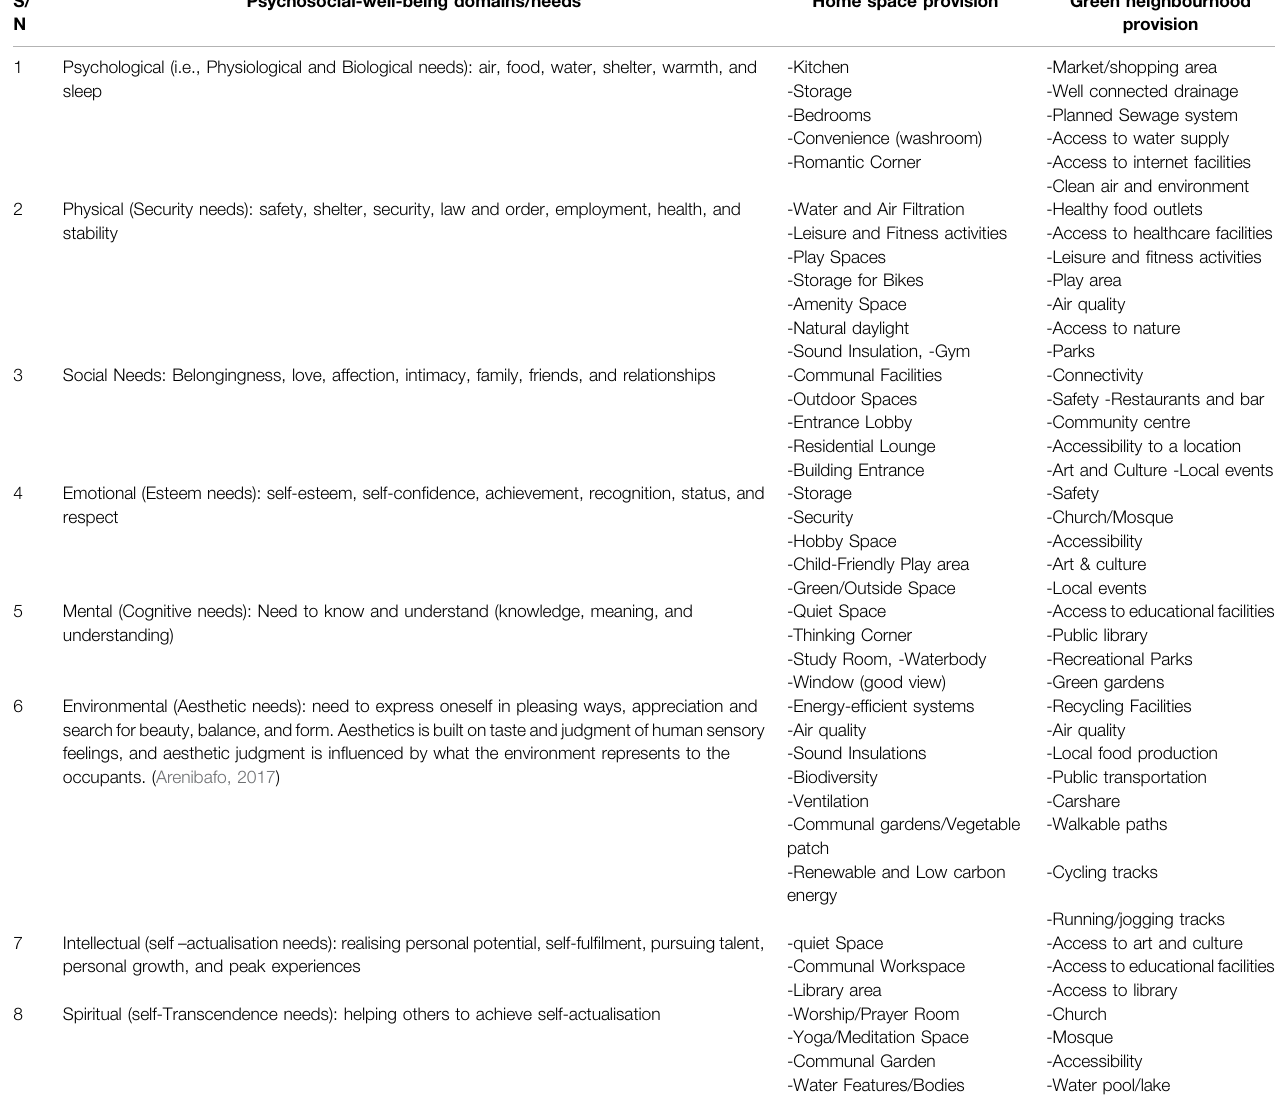
TABLE 1 | Psychosocial well-being domain and green neighbourhood connectivity. S/